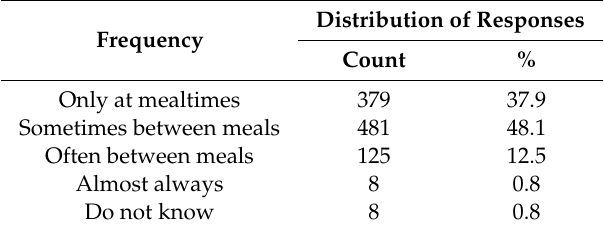
Table 6. The distribution of responses to the question: “How often do you feel hungry?” ( n = 1000). Frequency